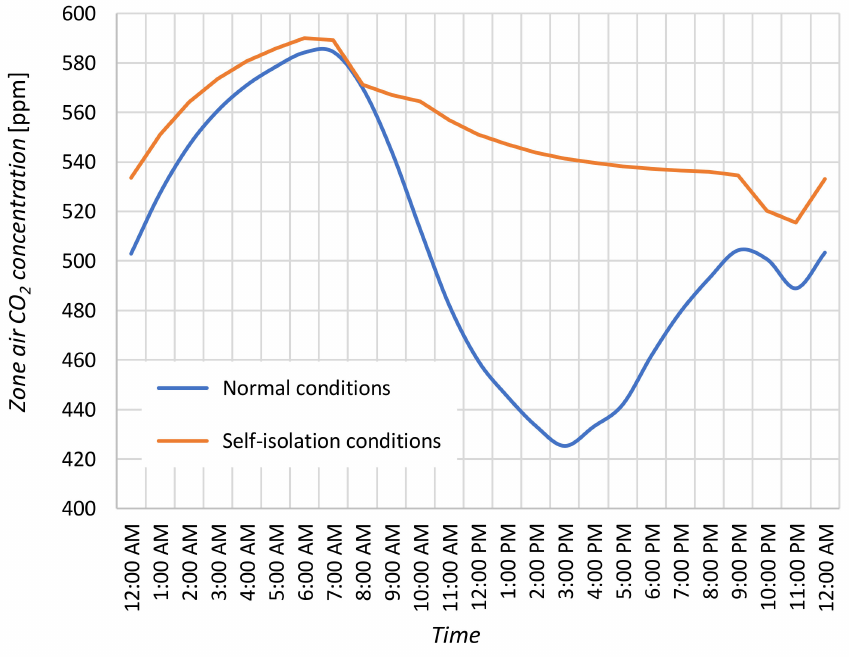
Figure 16. Change the CO 2 concentration for the presence of four people in the